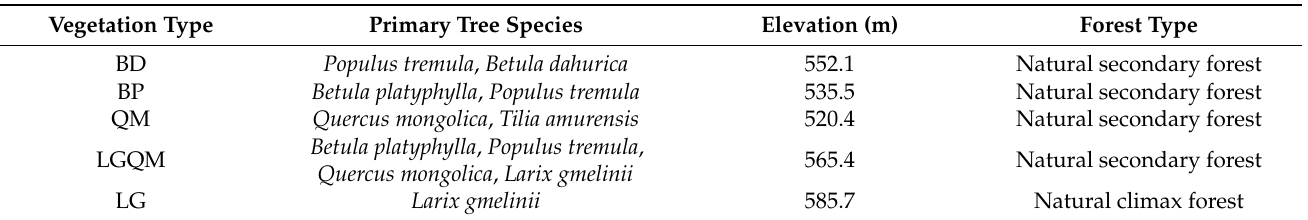
Figure 1. The asterisk indicates the study site in Heilongjiang Province and China. Table 1. Characteristics of the five naturally restored forest types in the Heilongjiang Zhongyangzhan Black-billed Capercaillie Nature